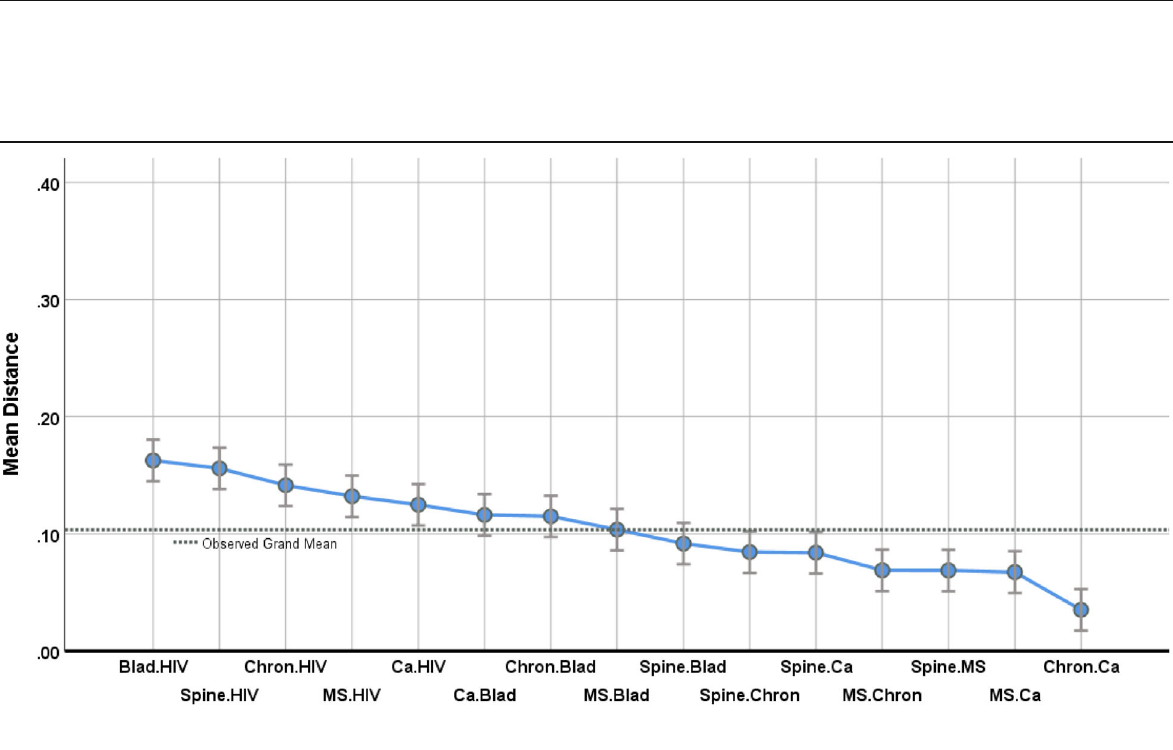
Fig. 1 Standards of Comparison: Z-to-r Distance between patient-group pairs for item-to-item correlations. This graph displays results from the first ANOVA. Each of 15 patient-group pairings is characterized on the Y-axis by the mean distance among 28 pairs of item-to-item correlations. Patient-group pairings showing similar item-to-item correlations (low mean distances) appear at right. Mean distances are widely dispersed, ranging from 0.04 to 0.35. 95% confidence-interval error bars are shown above and below the point estimate